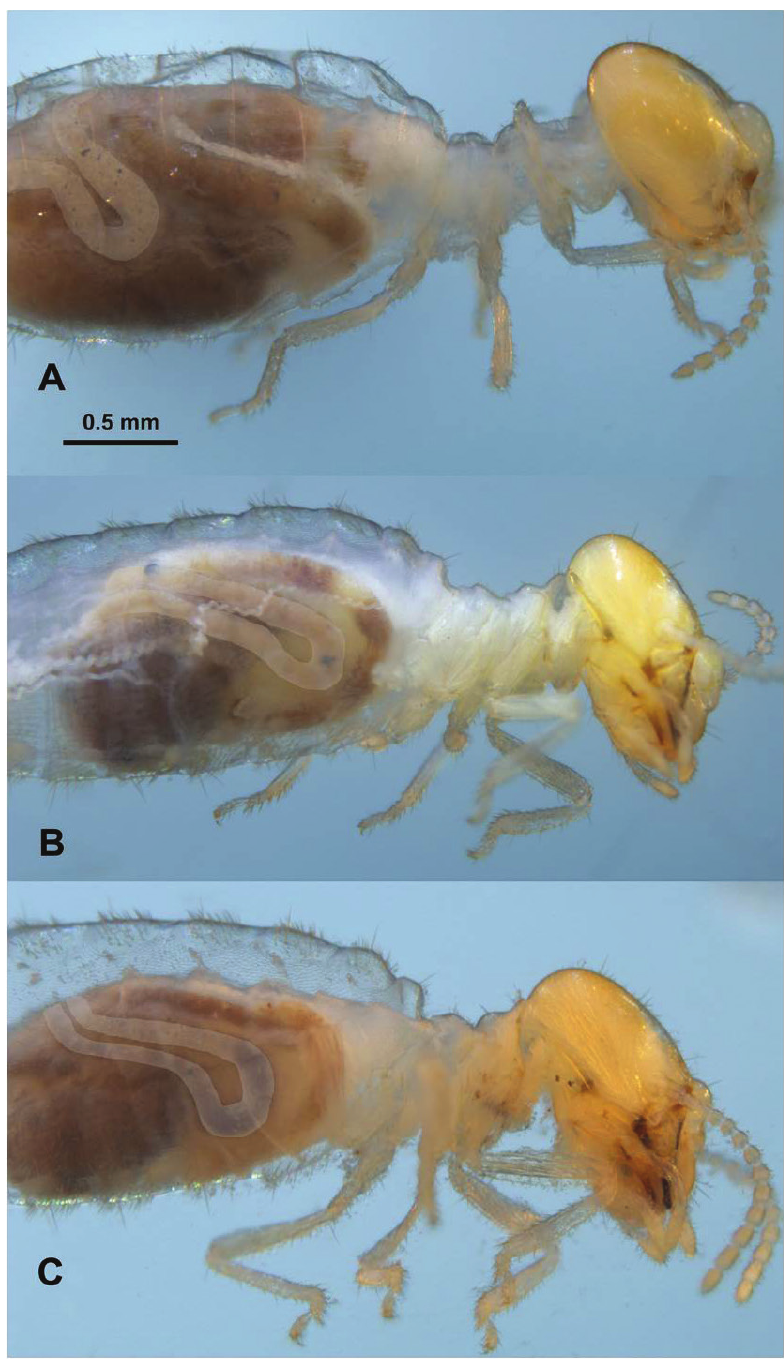
Figure 5. Parvitermes worker bodies with P1 highlighted. A P. mexicanus comb. n., dorsolateral view B P. mesoamericanus sp. n., ventrolateral view C P. yucatanus sp. n., ventrolateral